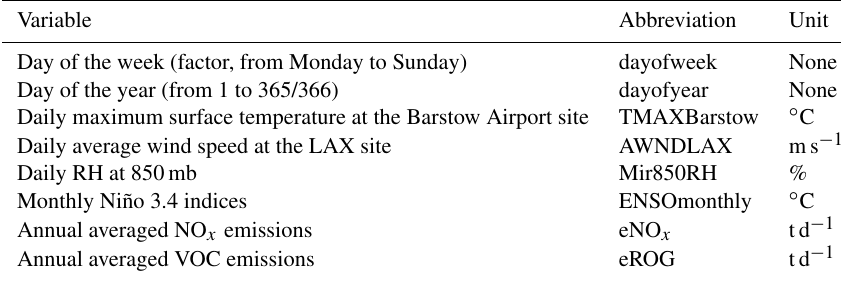
Table 1. Predictors used in the GAM and MARS model equations.